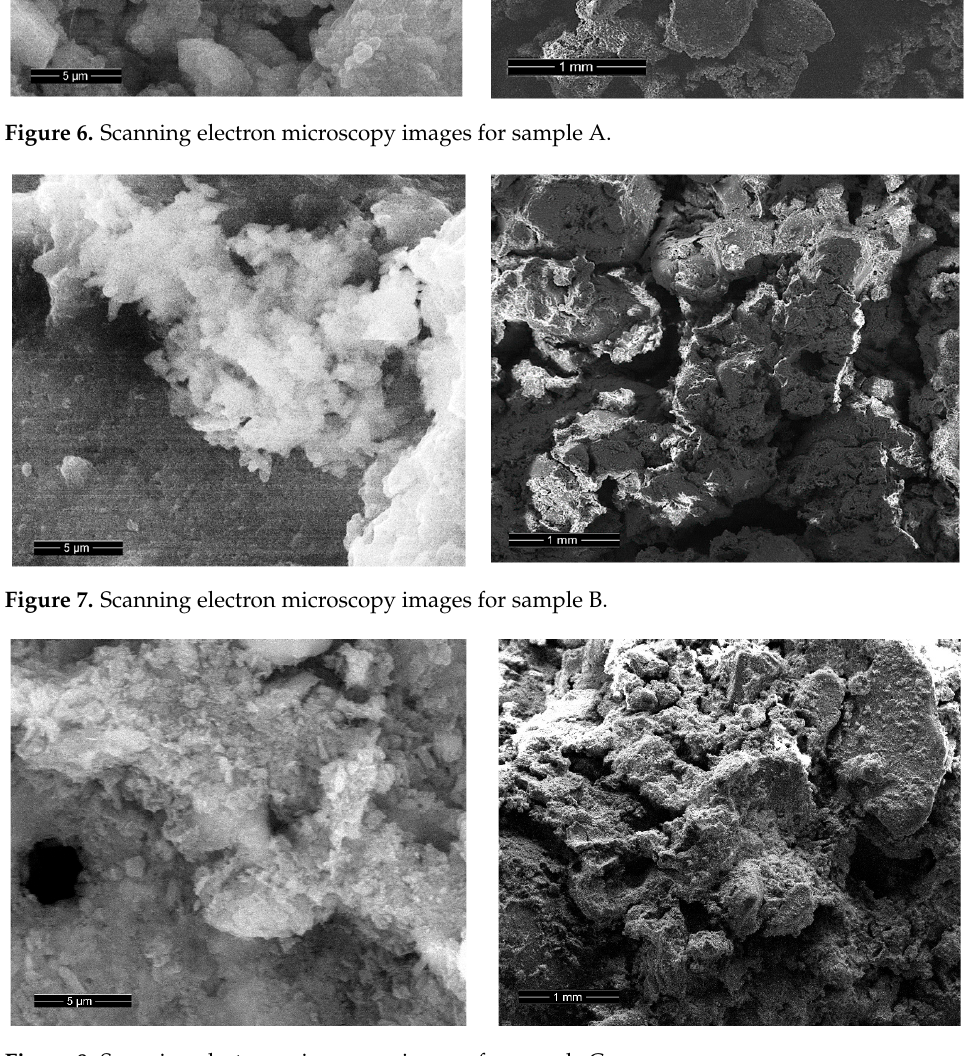
Figure 8. Scanning electron microscopy images for sample C.